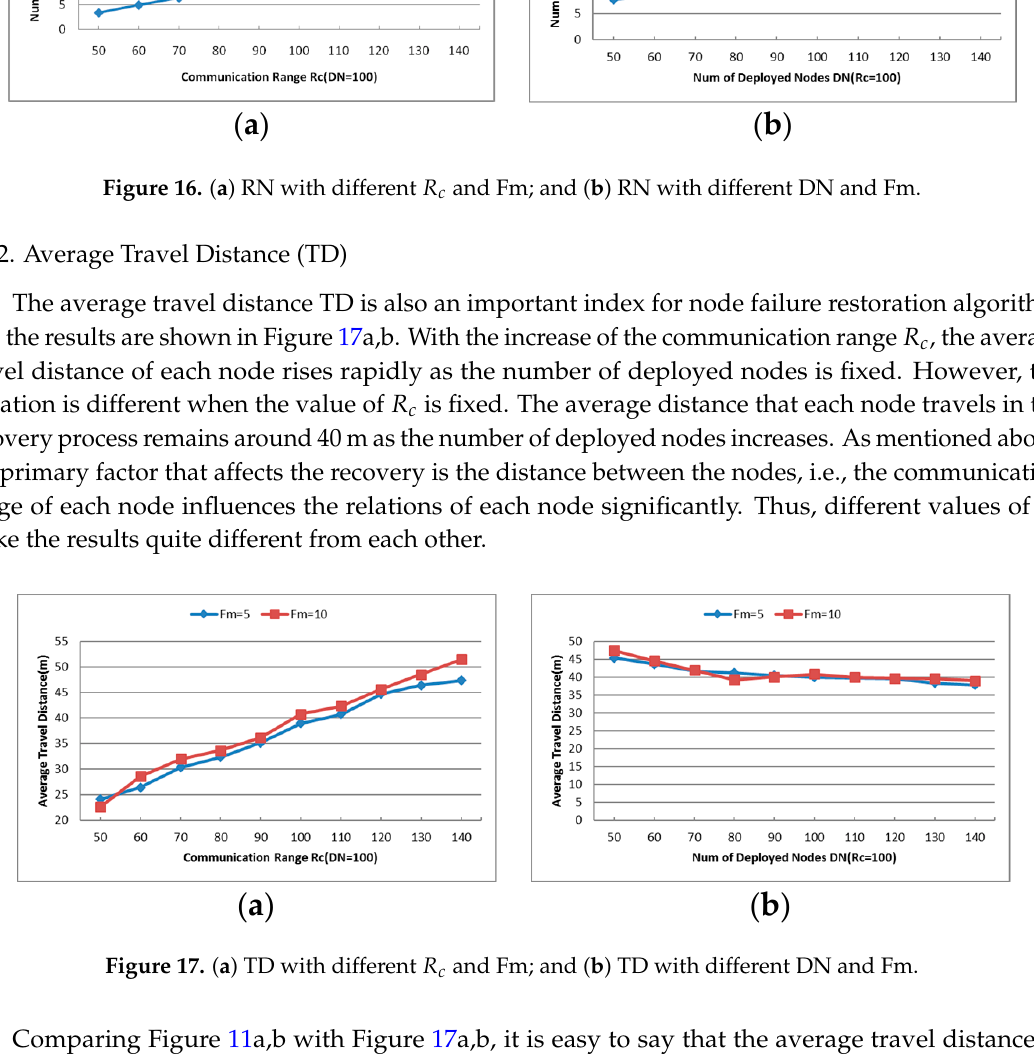
Figure 16. ( a ) RN with different (cid:1844)